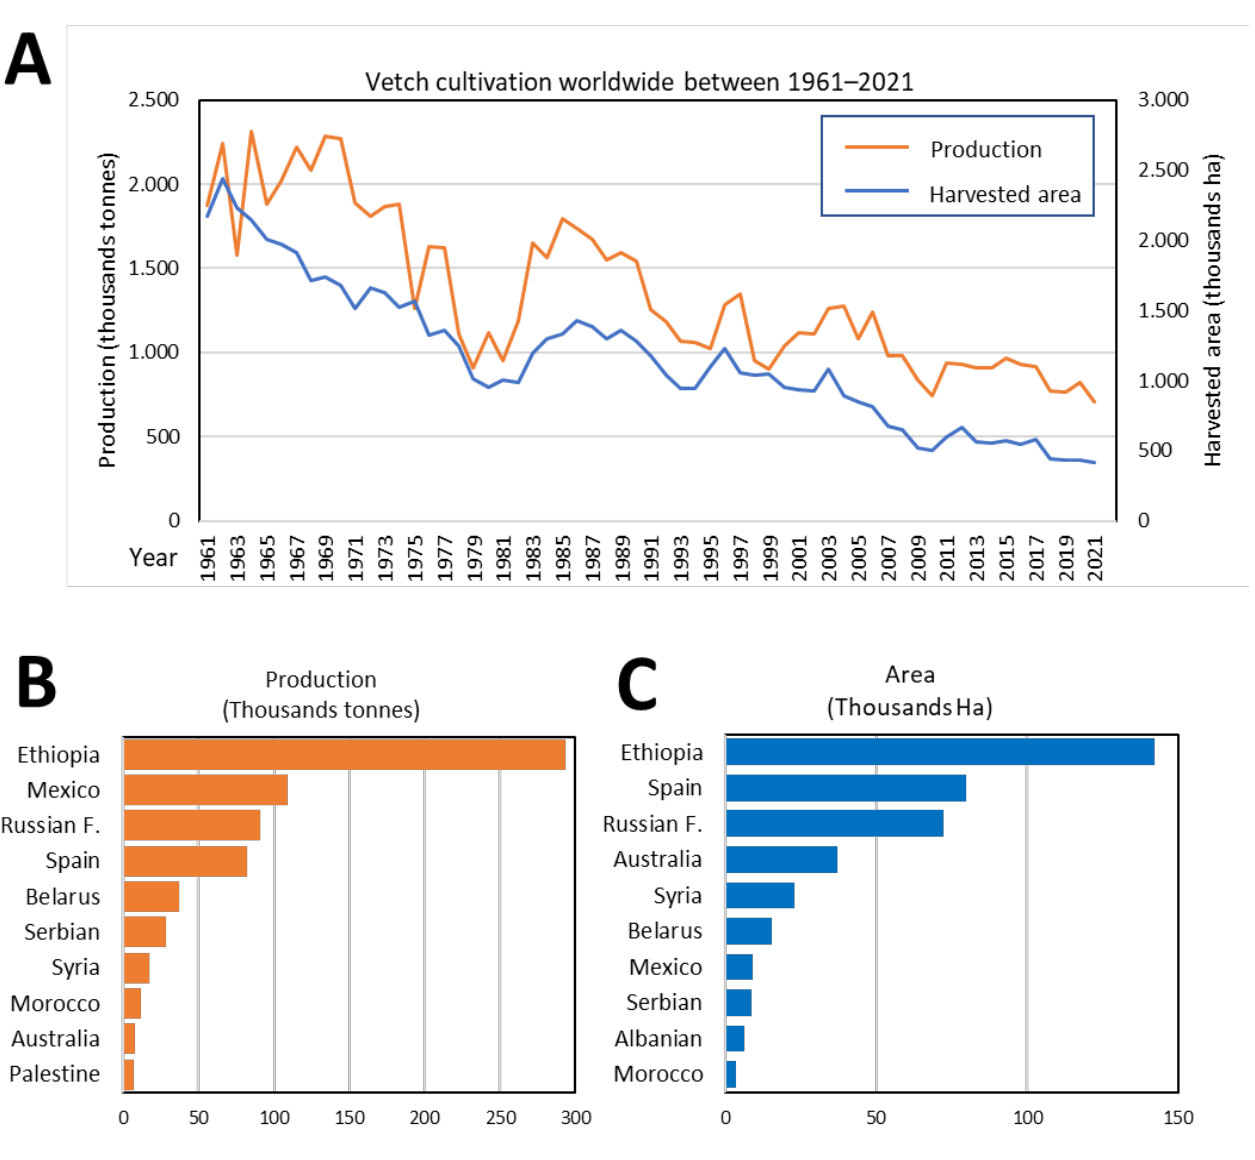
Figure 2. Worldwide V. sativa cultivation. ( A ) Production data and cultivated area of vetch worldwide during the last 60 years. Main producers according to cultivated area ( B ) or production ( C ) during the year 2021.